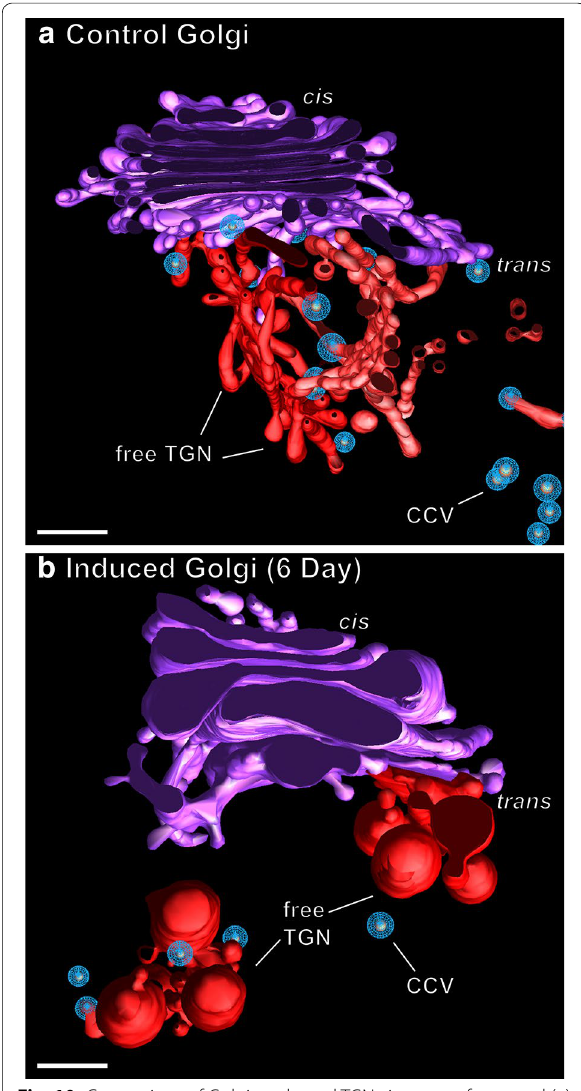
Fig. 10 Comparison of Golgi stacks and TGN cisternae of a control ( a ) and a 6 day-induced ( b ) Venus flytrap gland cell. Note the general swelling of the Golgi cisternae (purple) of the induced stack compared to the control stack. Similarly, the budding vesicles of the induced TGN cisternae (red) are much larger than those produced by the more slender, tubular TGN networks of the control Golgi. The number of clathrin-coated buds and vesicles (CCV) formed by the induced TGN cisternae is considerably reduced compared to the control TGN. Bars 0.2